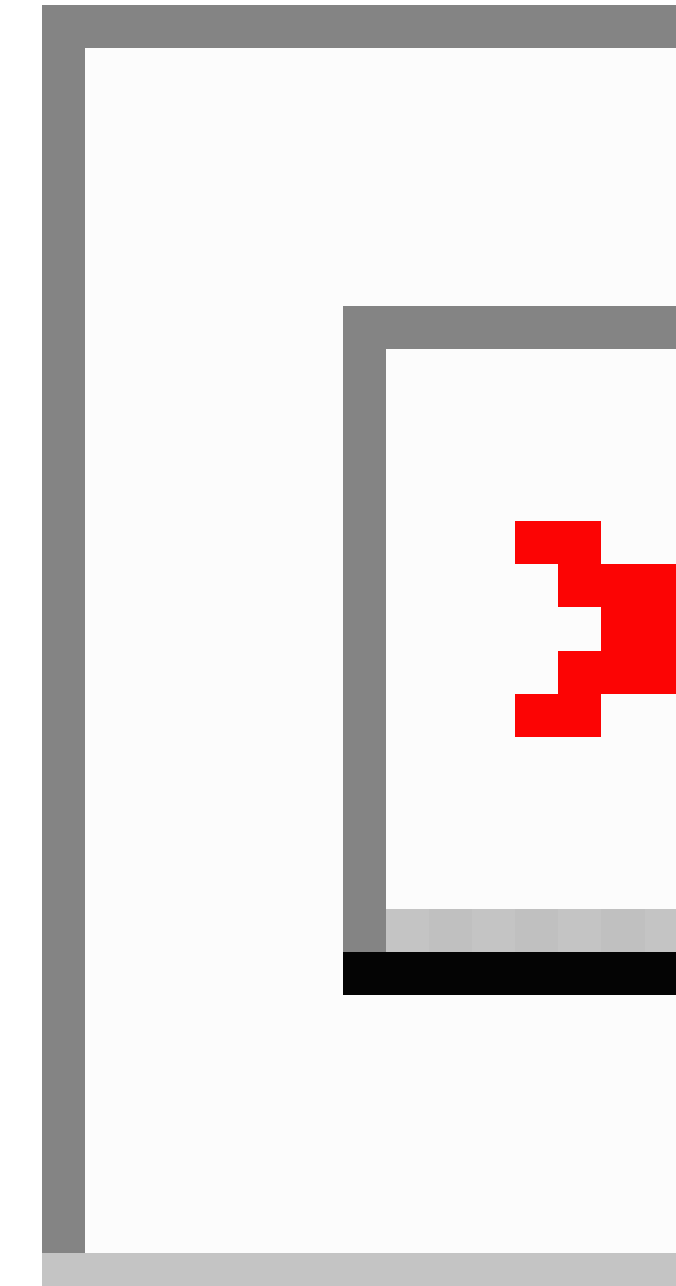
Figure 1. Flow diagram illustrating the study selection